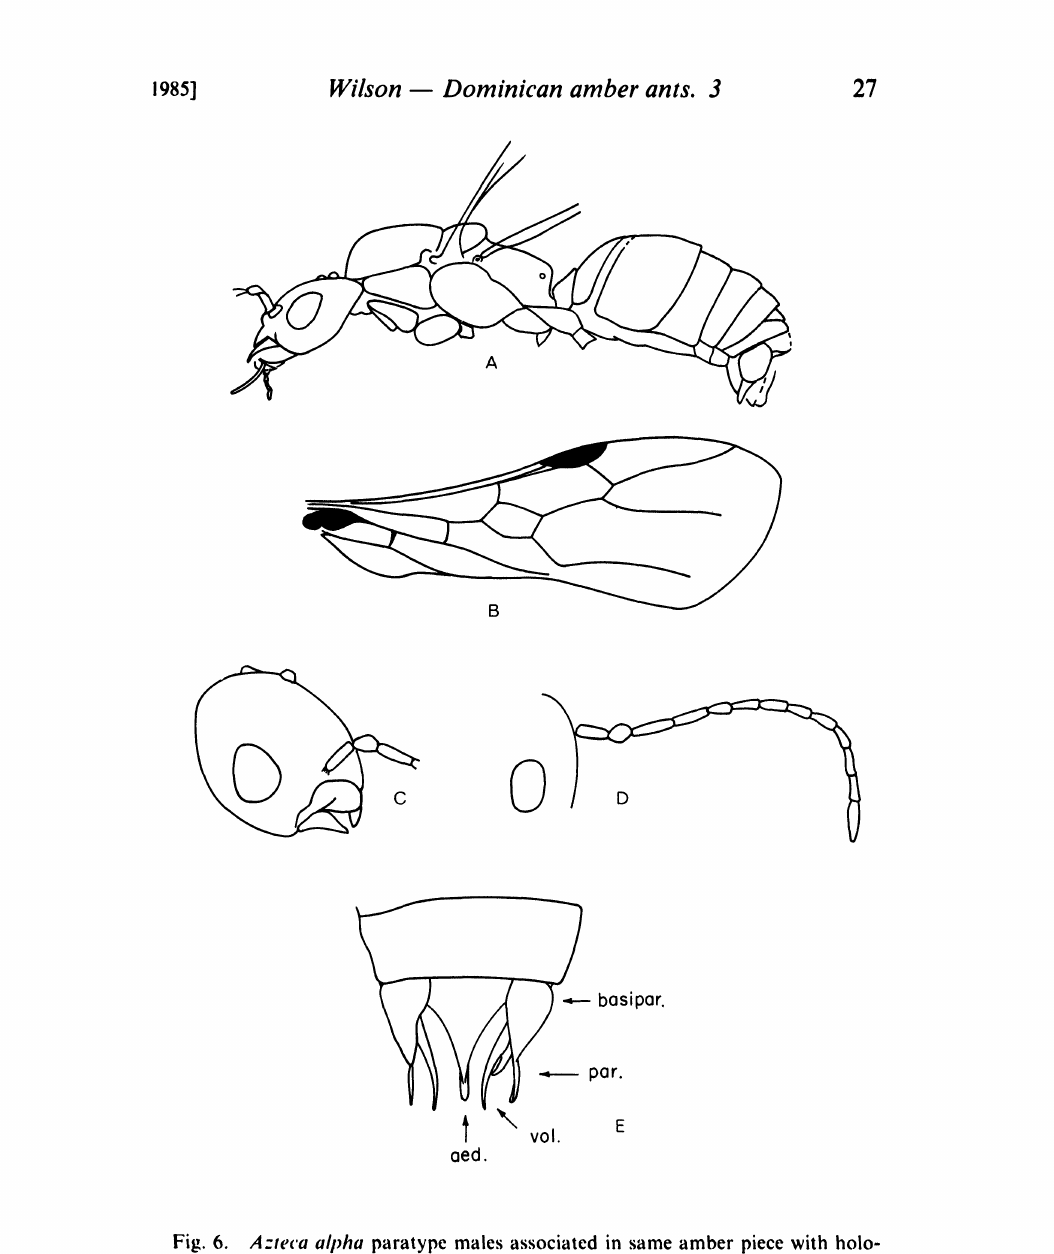
Fig. 6. Azteca alpha paratype males associated in same amber piece with holo- type worker. A, side view of body; B, left fore wing; C, oblique lateral view of right side of head: D, left antenna: E, dorsal view of genitalia (showing basiparamere, paramere, volsella,